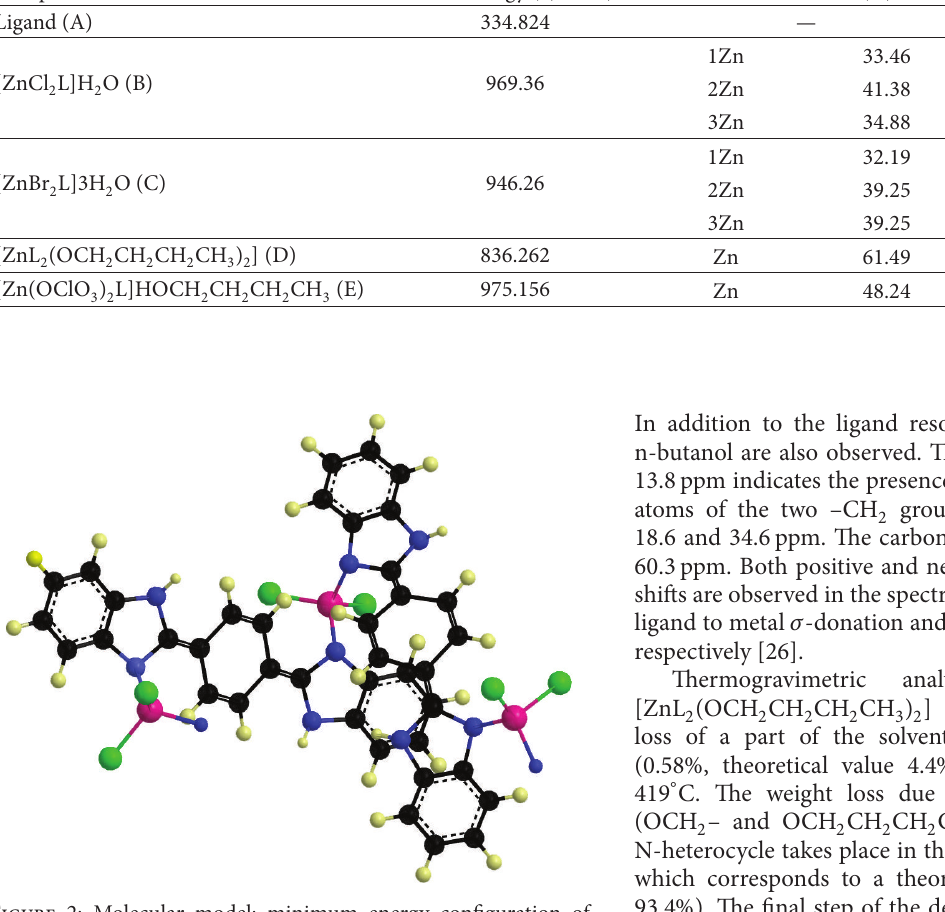
F 2: Molecular model: minimum energy con�guration